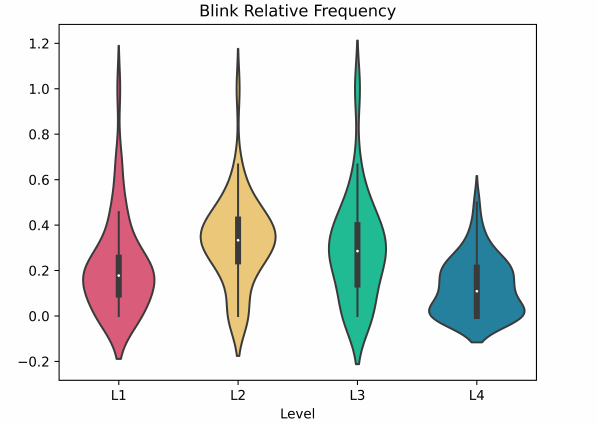
Figure 8. Violin plot of the Blink Relative Frequency across the four